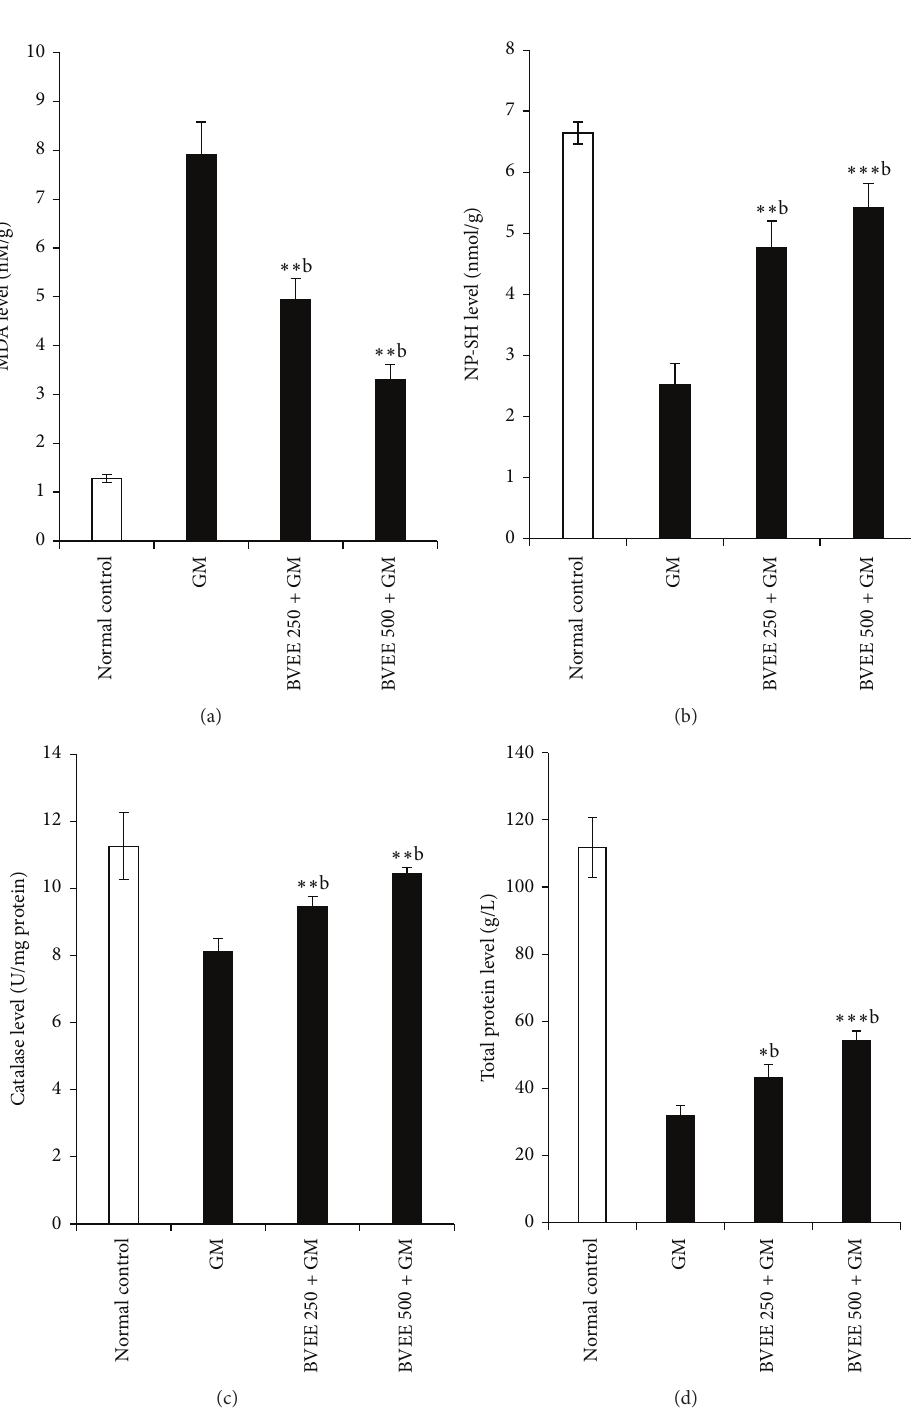
Figure 1: Effect of BVEE (250 and 500 mg/kg; p.o) on gentamicin induced nephrotoxicity on kidney lipid peroxidation: (a) MDA; (b) NP- SH; (c) catalase activity; and (d) total protein. The results are presented as the mean ± SEM. of six animals per group. “ ∗ , ∗∗ ” ∗ ∗ ∗ denotes significant differences from the control group ( 𝑃 < 0.05 , 𝑃 < 0.01 , and 𝑃 < 0.001 ); “ a , b , c ” denote significant differences from the GM group ( 𝑃 < 0.05 , 𝑃 < 0.01 , and 𝑃 < 0.001